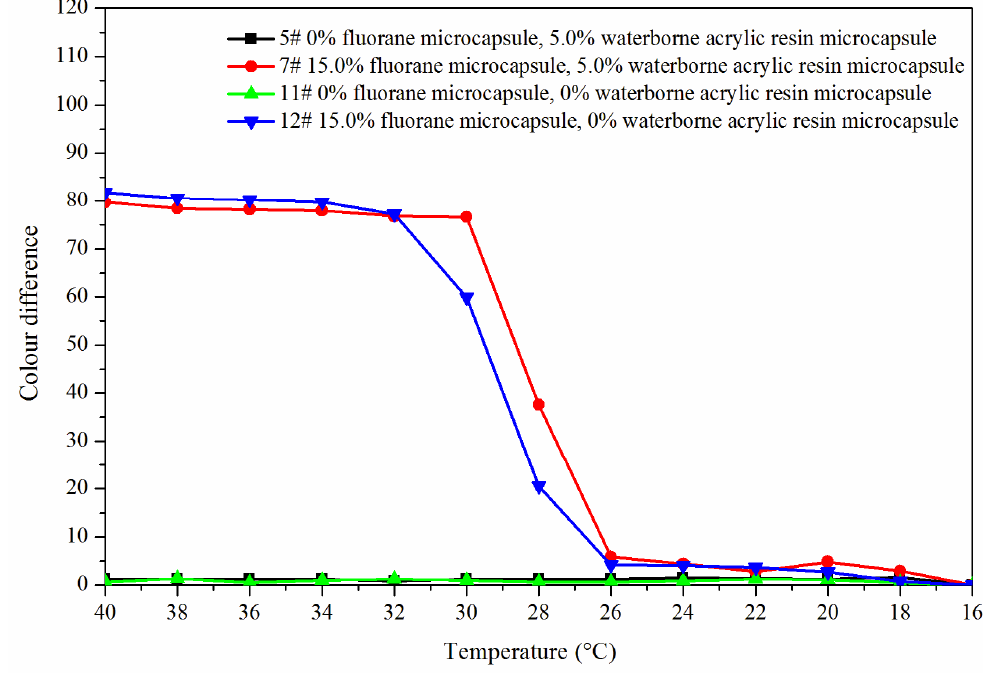
Figure 9. The color difference of the coating with the decreased temperature.